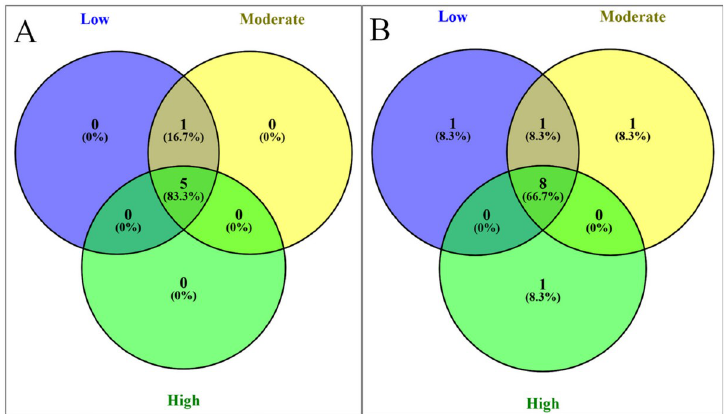
Fig 7. Shared and unique microalgae groups at SILVA classification levels 3 (A) and 4 (B) at stations with varying degrees of anthropogenic